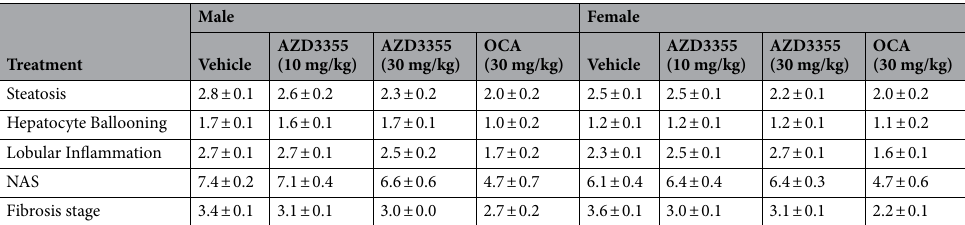
Table 2. NAFLD activity score (NAS) and fibrosis stage of AZD3355 treated mice.